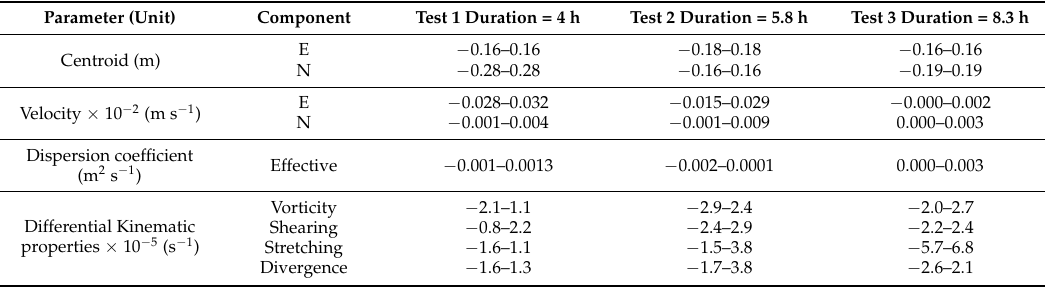
Table A1. Estimate of centroid, velocity, K c and DKP due to inherent position error; Values are 95% Confidence interval around the mean